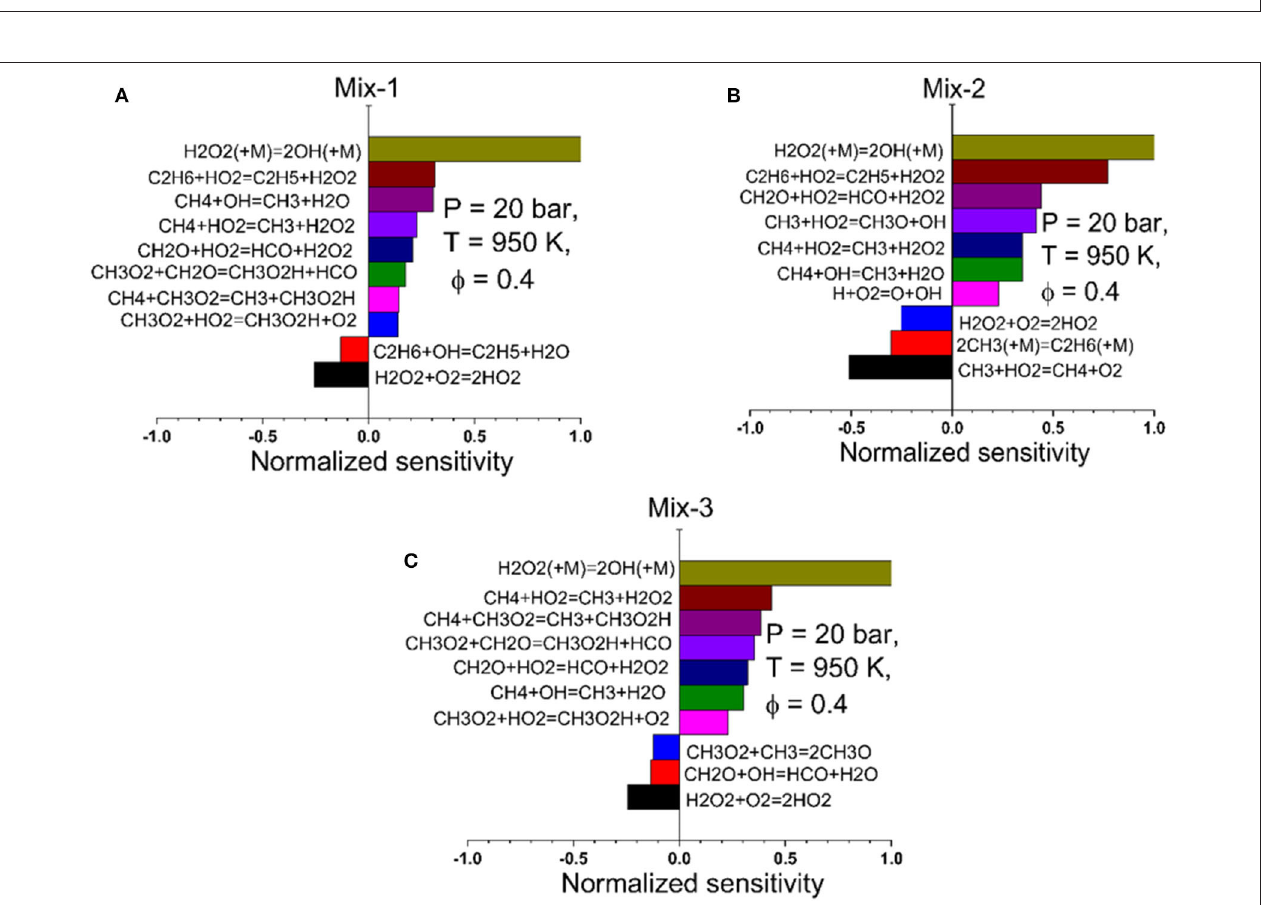
FIGURE 9 | Normalized sensitivity analysis on the OH radical at time of ignition for Mix 1 (A) , Mix 2 (B) , and Mix 3 (C) at 20 bar, 950K, and φ = 0.4 based on the NUIG n -hexane mechanism (Zhang et al., 2015).